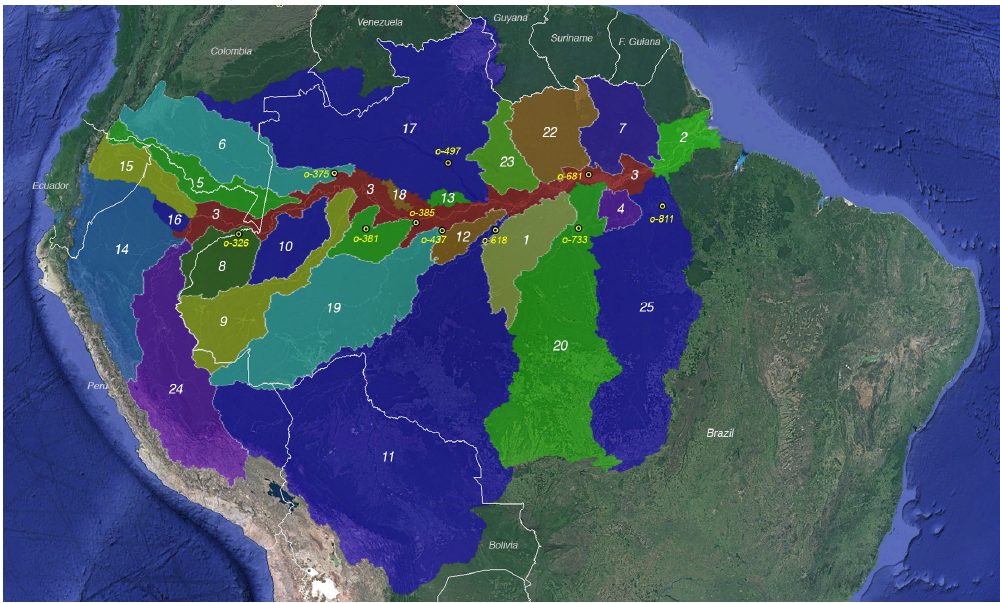
Figure 2. Amazon River basin catchment areas, basin level 2 (major tributary basins) as defined by Venticinque et al. [26] (Background: Google Earth). Table 1. River height gauging stations used to assess ScanSAR data representations of annual maximum and minimum flooding conditions across the basin. Values indicate the highest and lowest annual river stages recorded during the ALOS-2 PALSAR-2 acquisitions. Figures in brackets indicate the difference corresponding to the station maximum or minimum stage that same hydrological year.